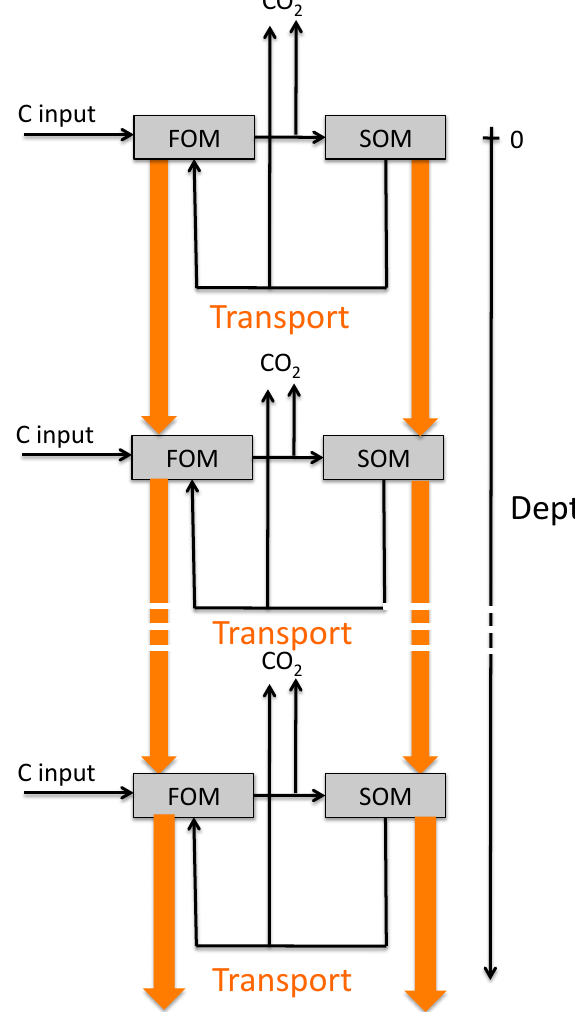
Fig. 1. Schematic representation of the fluxes and the pool in the